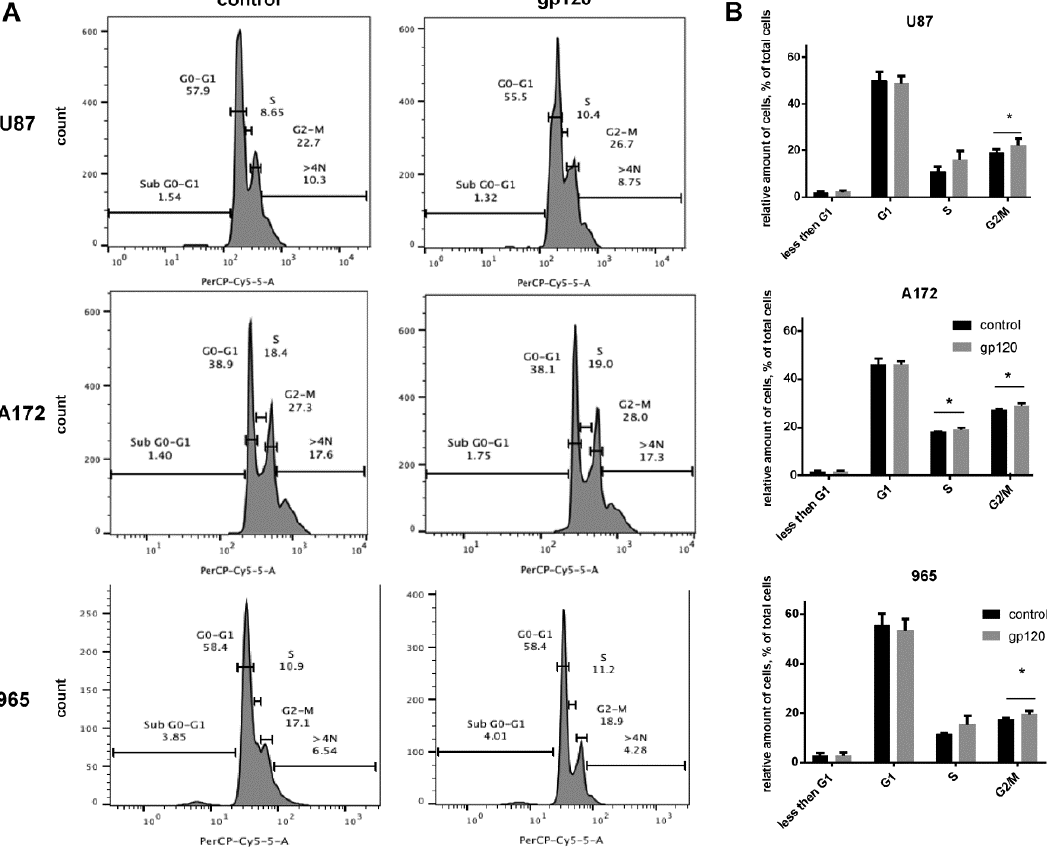
Figure 2. Gp120 stimulates proliferation of glioma cells. Cell cycle analysis was performed by analyzing cells stained with 7-aminoactinomycin D (7AAD) with flow cytometry. The percentage of cells in the G0/G1, S and G2/M phases was determined based on DNA content. Experiments were performed for untreated glioma cells and cells continuously treated with gp120 for 10 days. U87 and A172 cell lines and 965 primary glioma cells were investigated. ( A ) Histograms and ( B ) bar graphs represent the total distribution of cells at different phases of the cell cycle. The proportion of cells at each phase of mitosis is shown as a percentage of the total number of cells. Mean ± S.E. and significant differences from control (*) are shown ( p < 0.05). Unpaired t -tests were used to determine the significance between groups. Four repeated experiments ( n = 4) were used for statistical analysis. Based on these results we calculated the duplication time for cells treated with gp120 ( 1 ) and untreated ( 2 ).